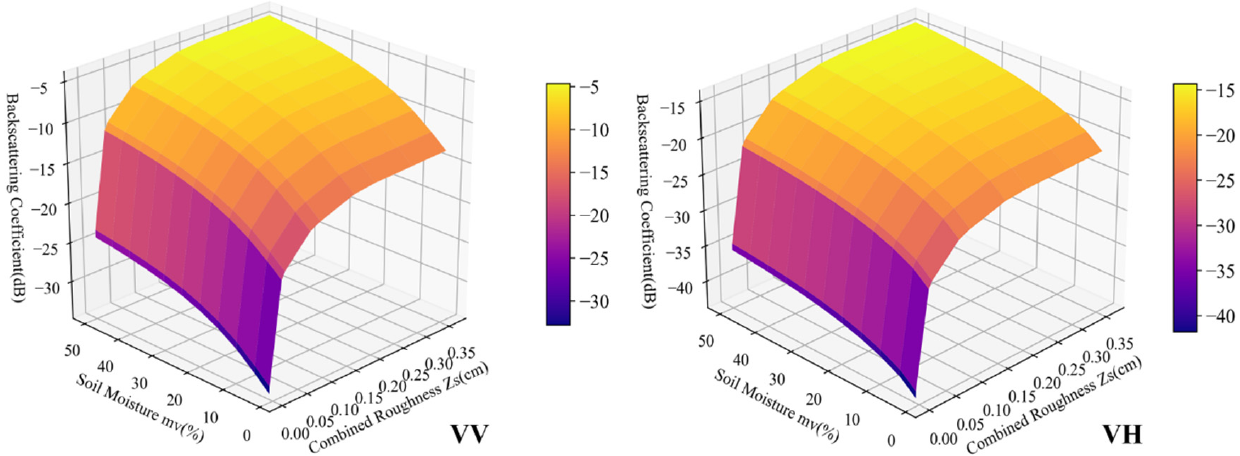
Figure 3. Response of backscattering coefficient to the surface parameters with AIEM (mv is soil moisture content).